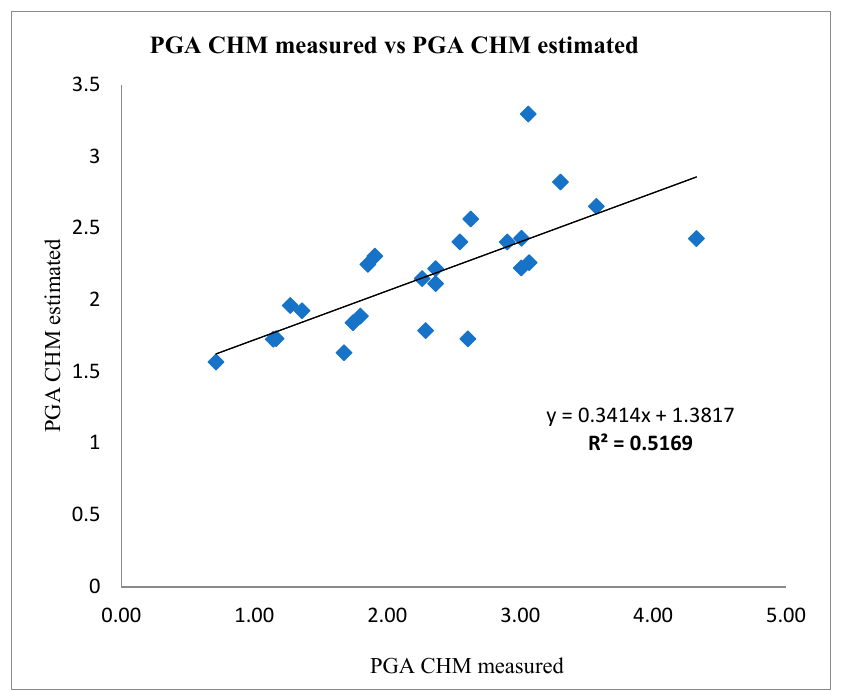
Figure 7. Measured vs. estimated CHM PGA with NDVI values > 0.35 of Tonda di Giffoni, using